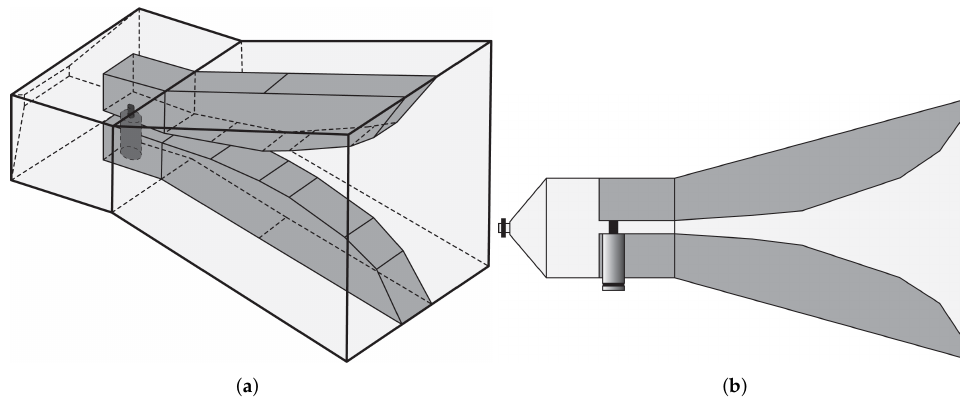
Figure 31. Geometry of the double-ridged horn antenna ( a ) 3-D view ( b ) side view (redrawn from [124]). Medium grey ridges and light grey outer metal.